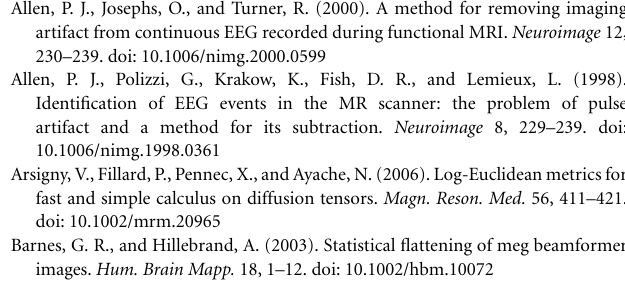
Table S1 | Freesurfer subcortical and cortical regions used in this work to define brain connectomes. Figure S1 | Average functional connectivity matrices across subjects in fMRI and EEG δ , θ , α , β , and γ bands, respectively. The Hilbert envelope of the EEG signal was averaged within each epoch (AWE), which is equal to the fMRI-TR. Therefore, both fMRI and EEG time series have the same number of time samples. (A–F) Depicts the partial correlation within cortical regions (68 × 68), whereas (G–L) demonstrates the partial correlation within subcortical regions (82 × 82). The regions are given in Table S1 and they are ordered similarly to their matrix representation. For the cortical regions, the top left matrix quadrant represents connections within left hemisphere (lh), the bottom right represent connections within the right hemisphere (rh), and the remaining quadrants represent inter-hemispheric connections. At (G–L) , the subcortical regions have been added at the top left corner of the connectivity matrices. This figure is similar to Figure 2 with a noticeable decrease of the partial correlation across all EEG bands. This may be due to less time samples that would result in under-estimation of true connectivity due to the regularization. Figure S2 | The connections with the 15% highest absolute value in Figure S1 (AWE) are shown as 3D graphs in standard space. Connections are represented as cylinders with salmon color when they are positive and slate-gray when they are negative. Brain regions are represented with spheres. Their centers and radii represent the centers of mass of each underlying region and its volume, respectively. The color-coding corresponds to different parts of the brain. (A–F) Shows partial correlation networks within cortical regions, whereas (G–L) shows partial correlation networks within cortical and subcortical regions. Figure S3 | Results derived from randomized Lasso for the AWE case. These reflect the 2% connections with the highest probability to be selected overall sCCA repetitions. (A–F) Shows results with the precision matrices derived based on cortical regions only, whereas (G–L) shows the results obtained with precision matrices that include both cortical and subcortical